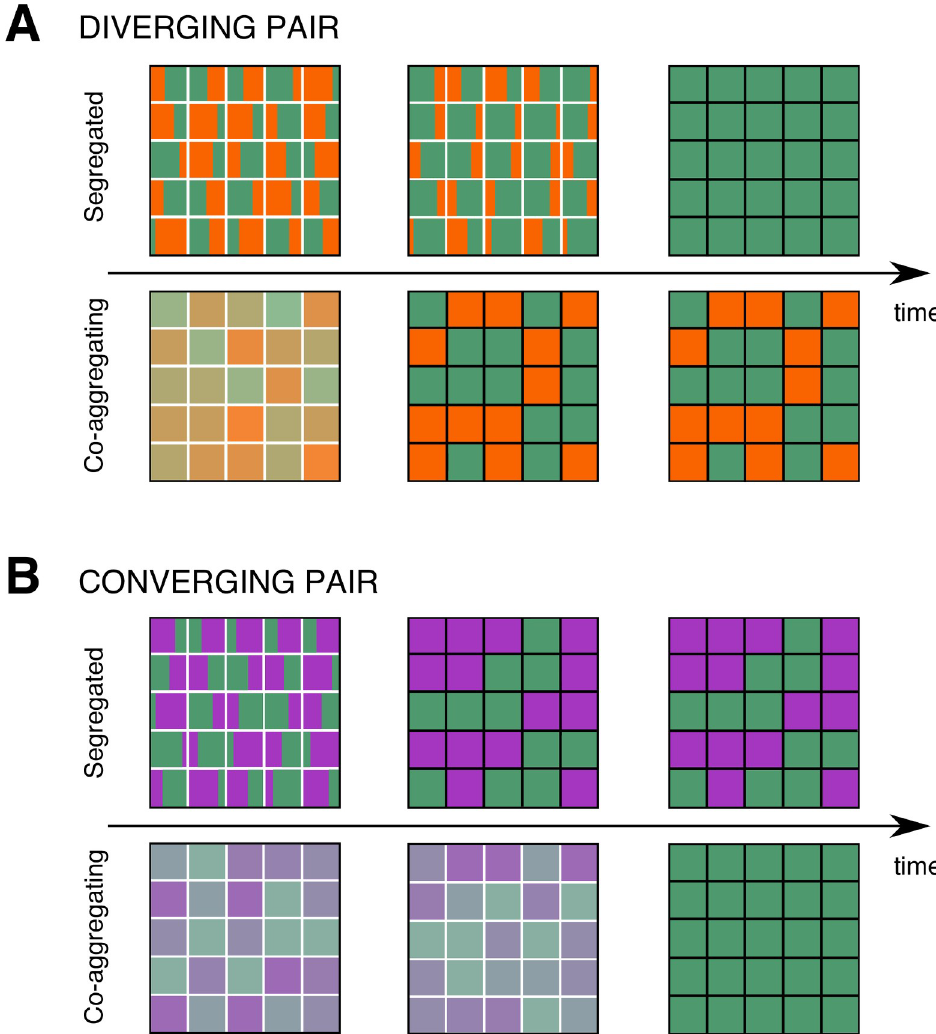
Fig 6. Model results of the effects of developmental interactions on transient alpha diversity and stationary beta diversity in an environment discretized into 25 patches (see S9 Fig). (A, B) White interior boundaries symbolize a transient patch-level population composition; black interior boundaries symbolize a stationary patch-level population composition. (A) Strains diverge in their partitioning behavior because of developmental interactions during coaggregation. In a stochastic environment with mean starvation time � T = 430 hours (symbol with black boundary in st Fig 5E), the mean extinction time decreases (decreased transient alpha diversity), but the variability in the winner across patches increases compared to segregated development (increased stationary beta diversity). (B) Strains converge in their partitioning behavior because of developmental interactions during coaggregation. In a stochastic environment with mean starvation time � T = 448 hours (symbol with black boundary in Fig 5E), coaggregation st increases transient coexistence (and transient alpha diversity) relative to segregation. However, it also eliminates the variability in the winner and thus stationary beta diversity. In both (A) and (B), snapshots are taken for the initial condition (left column), at an intermediate time at which scenarios with lower alpha diversity have reached the stationary state (central column), and when both coaggregation and segregated development have reached stationarity (right column). complexes, such as free-riding, whereby individuals reap the benefits of group living without paying the costs. In slime molds, free riders—strains that never contribute to stalk formation in mixes—have been found both in the wild [45] and in the lab [46]. If under selection, these heritable loners, invulnerable to the threats to the multicellular stage but capable of reachieving